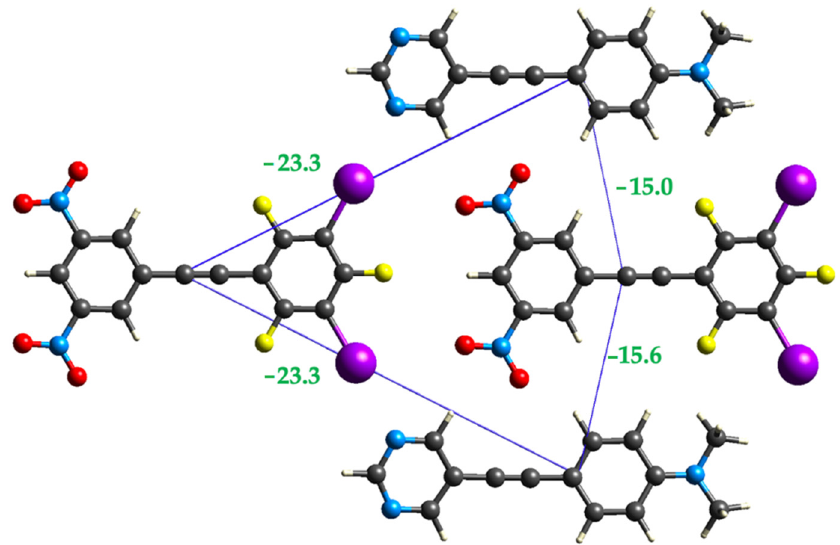
Figure 9. Crystal Explorer interaction energies (in kJ/mol) for halogen bonds and side-by-side interactions between halogen bond donor and acceptor. Table 2. Intermolecular distances (in Å) and interaction energies (in kJ/mol) for the halogen bonded molecules and the D-A side-by-side interactions in cocrystal 1 • 3 . Interaction Type Interaction